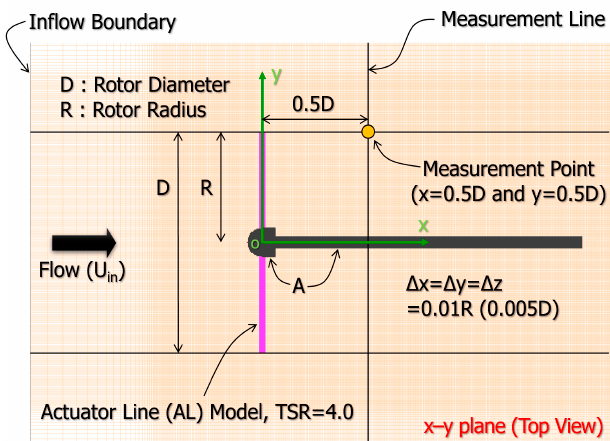
Figure 6. Computational grid in numerical simulation for wind-tunnel experiment using wind-turbine scale model: x–y plane (top view).